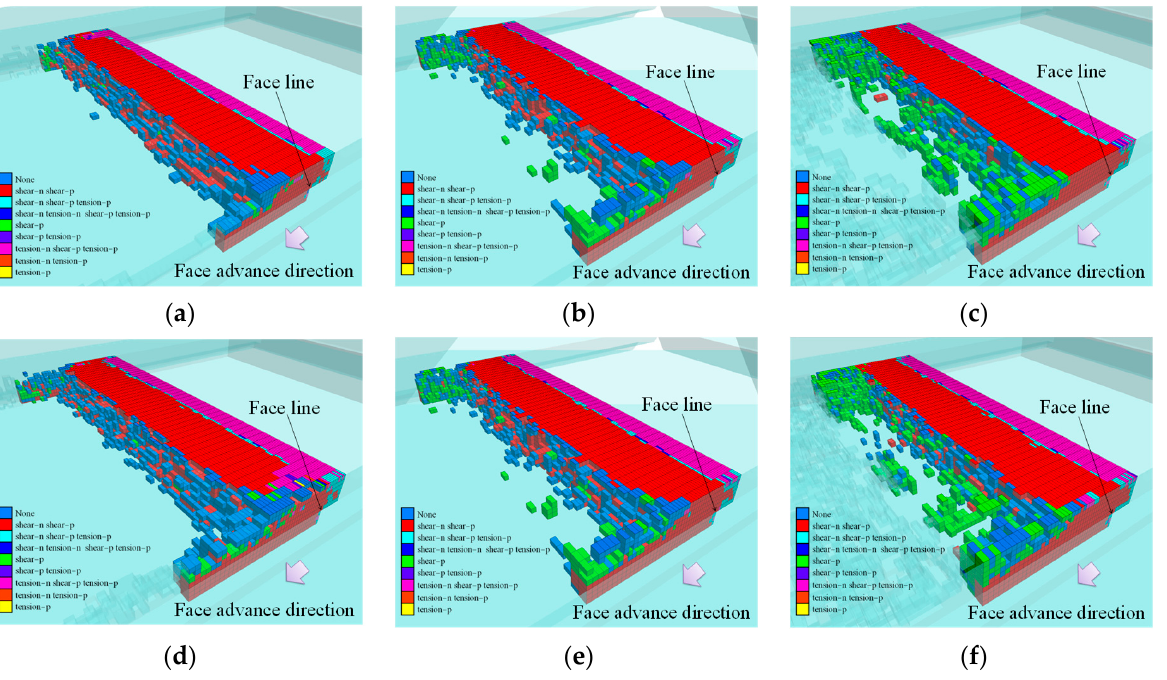
Figure 17. Influence of hydraulic fractures on failure zone of top ‐ coal. ( a ) Model I; ( b ) Model II; ( c ) Model III; ( d ) Model IV; ( e ) Model V; ( f ) Model VI.